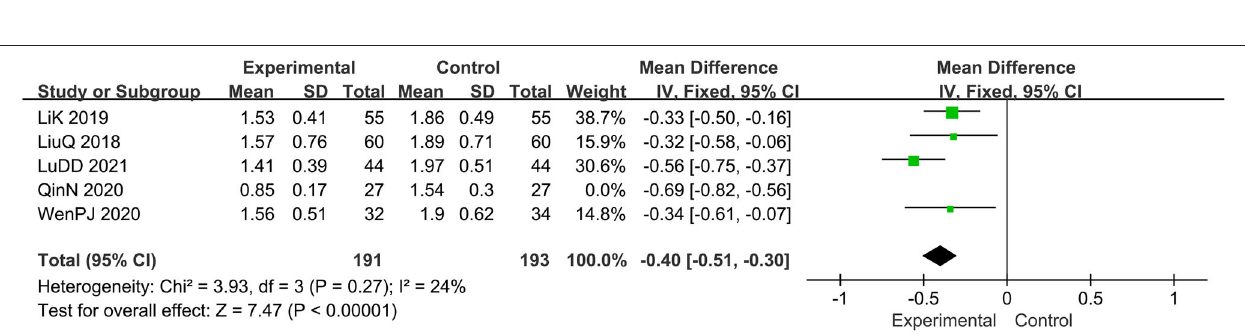
FIGURE 4 | The meta-analysis for comparison of combination therapy vs. prednisone for the outcome of the score of lesions.